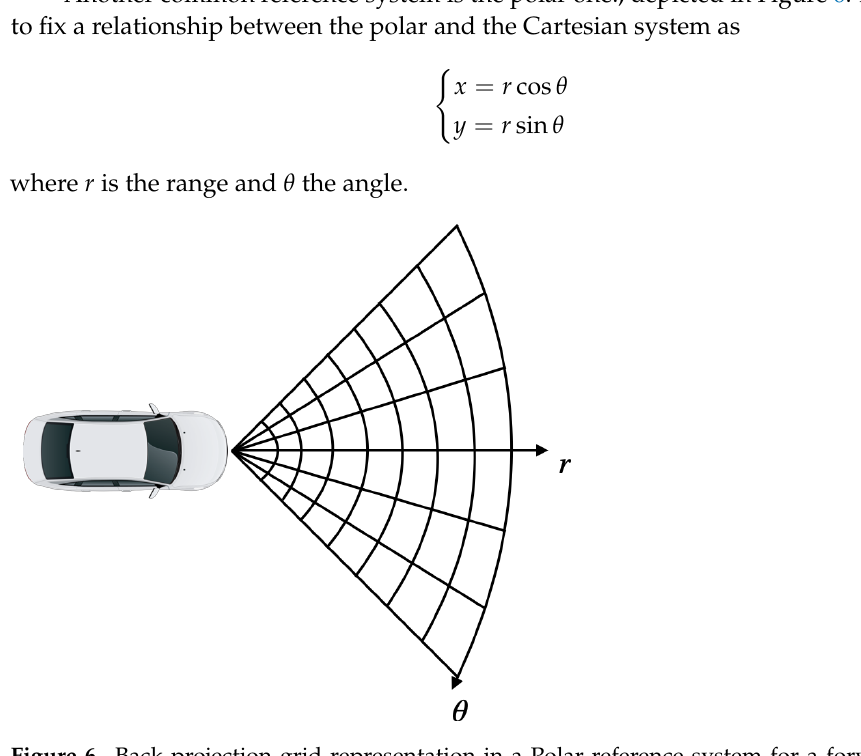
Figure 6. Back projection grid representation in a Polar reference system for a forward looking Automotive SAR.